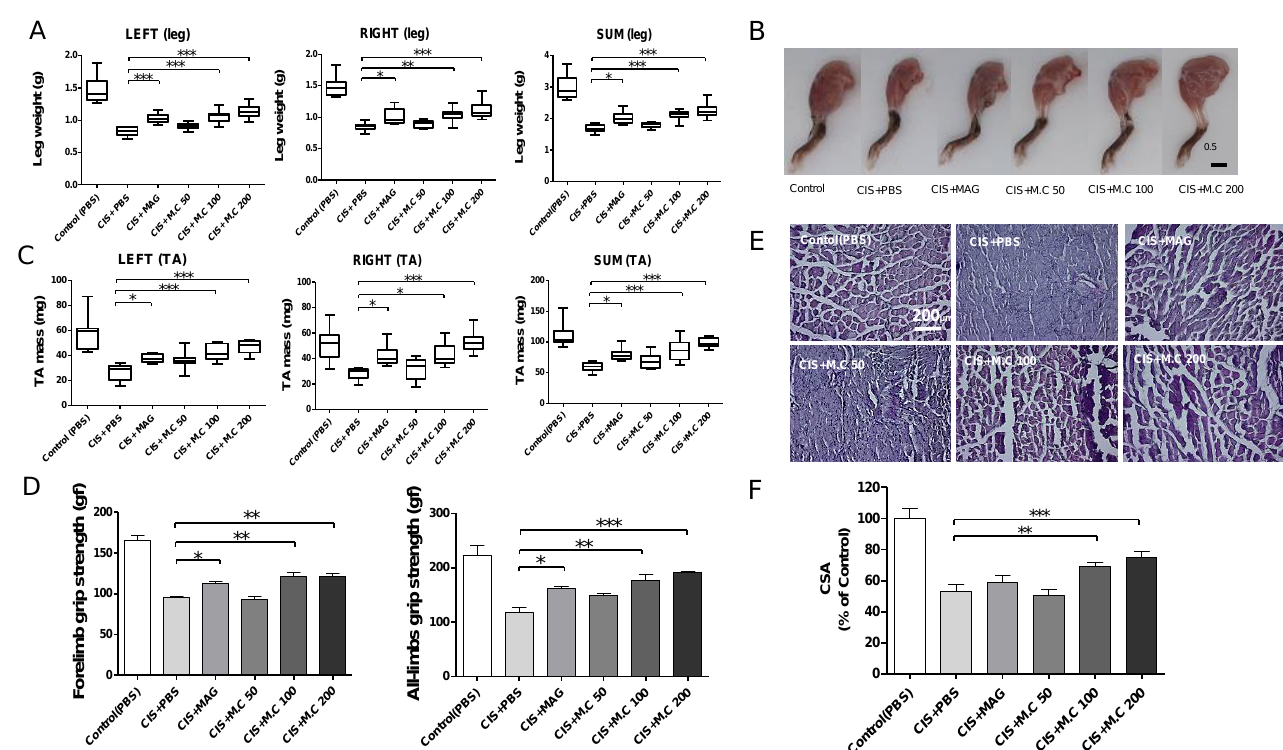
Figure 3. M.C alleviated muscle wasting induced by the cisplatin treatment in mice. The effect on muscle was evaluated by measuring leg mass, TA (tibialis anterior) muscle mass, fiber diameter, and grip strength. Data were obtained from the mouse leg tissue on day 42: ( A ) leg muscle mass; ( B ) representative leg images (scale bar 0.5 cm); ( C ) TA muscle mass; ( D ) The grip strength was measured using behavioral tests in front legs and in all legs; ( E , F ) hematoxylin and eosin (H&E) staining of TA muscle (scale bar 200 µ m) and cross-sectional area (CSA) analysis. Data are presented as the mean ± SEM ( n = 10/group in A–C, n = 5/group in E–D). * p < 0.05, ** p < 0.01, *** p < 0.001 vs. CIS+PBS, using a Bonferroni post hoc test after one-way